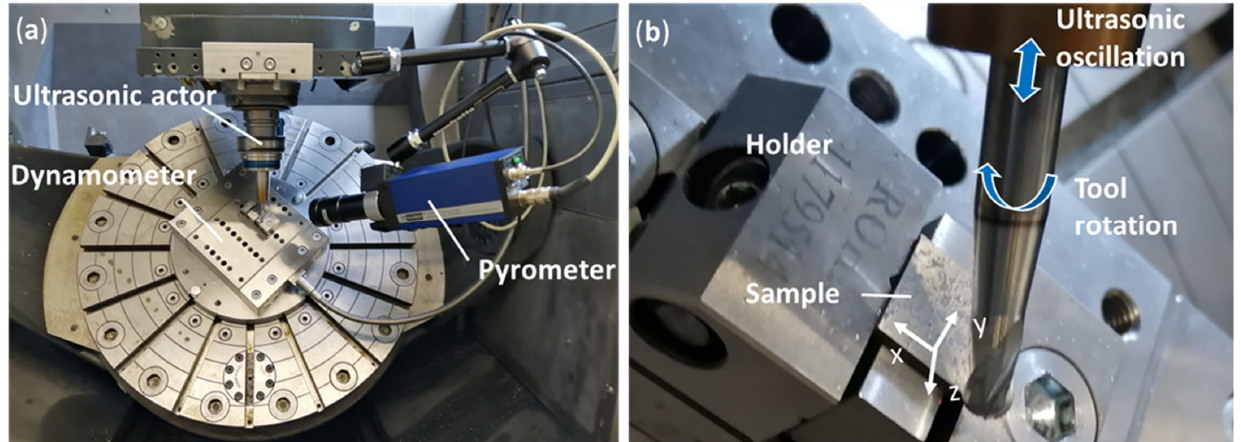
Figure 2. ( a ) Experimental setup for milling experiments with in situ measurement of cu tt ing forces and temperature on cu tt ing edge. ( b ) Close-up of tool–workpiece orientation with axes of experi- forces and temperature on cutting edge. ( b ) Close-up of tool–workpiece orientation with axes of mental setup and tool kinetics. experimental setup and tool